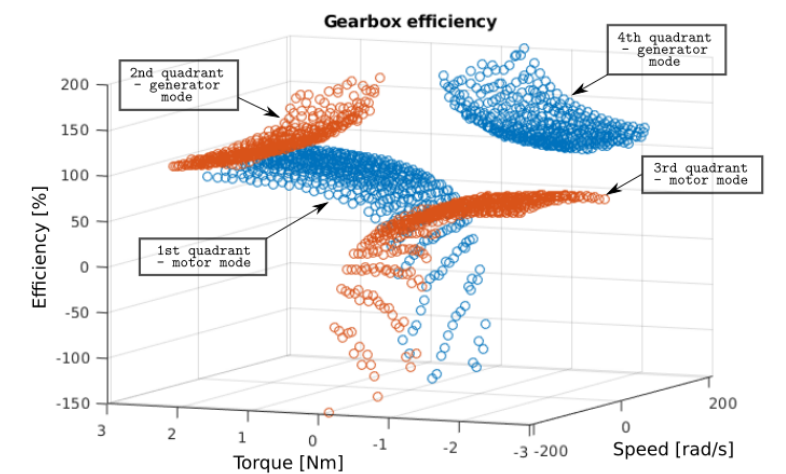
Figure 4. Four-quadrant visualisation of efficiency points of the gearbox, obtained by experimental